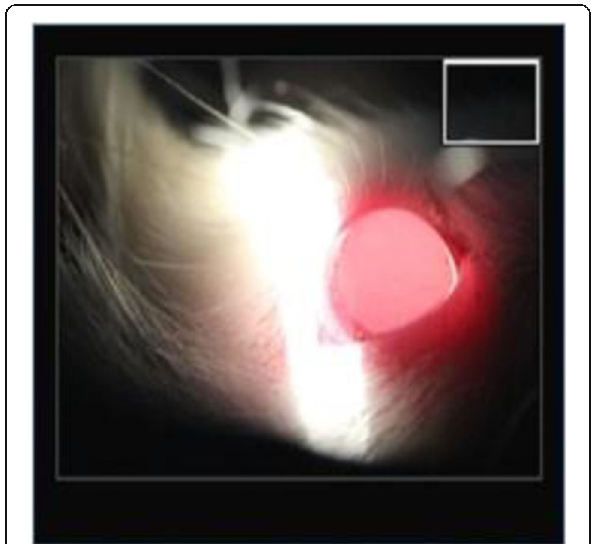
Fig. 4 Slit lamp photography of group 4 (diabetic model treated with TUDCA) showing clear